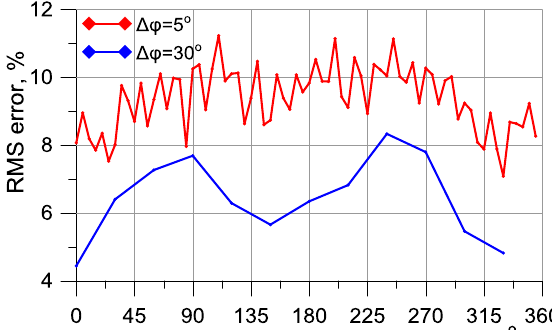
Fig. 8. RMS Error of angular relative concentration distribution for sectors division Δφ=5° and Δφ=30°